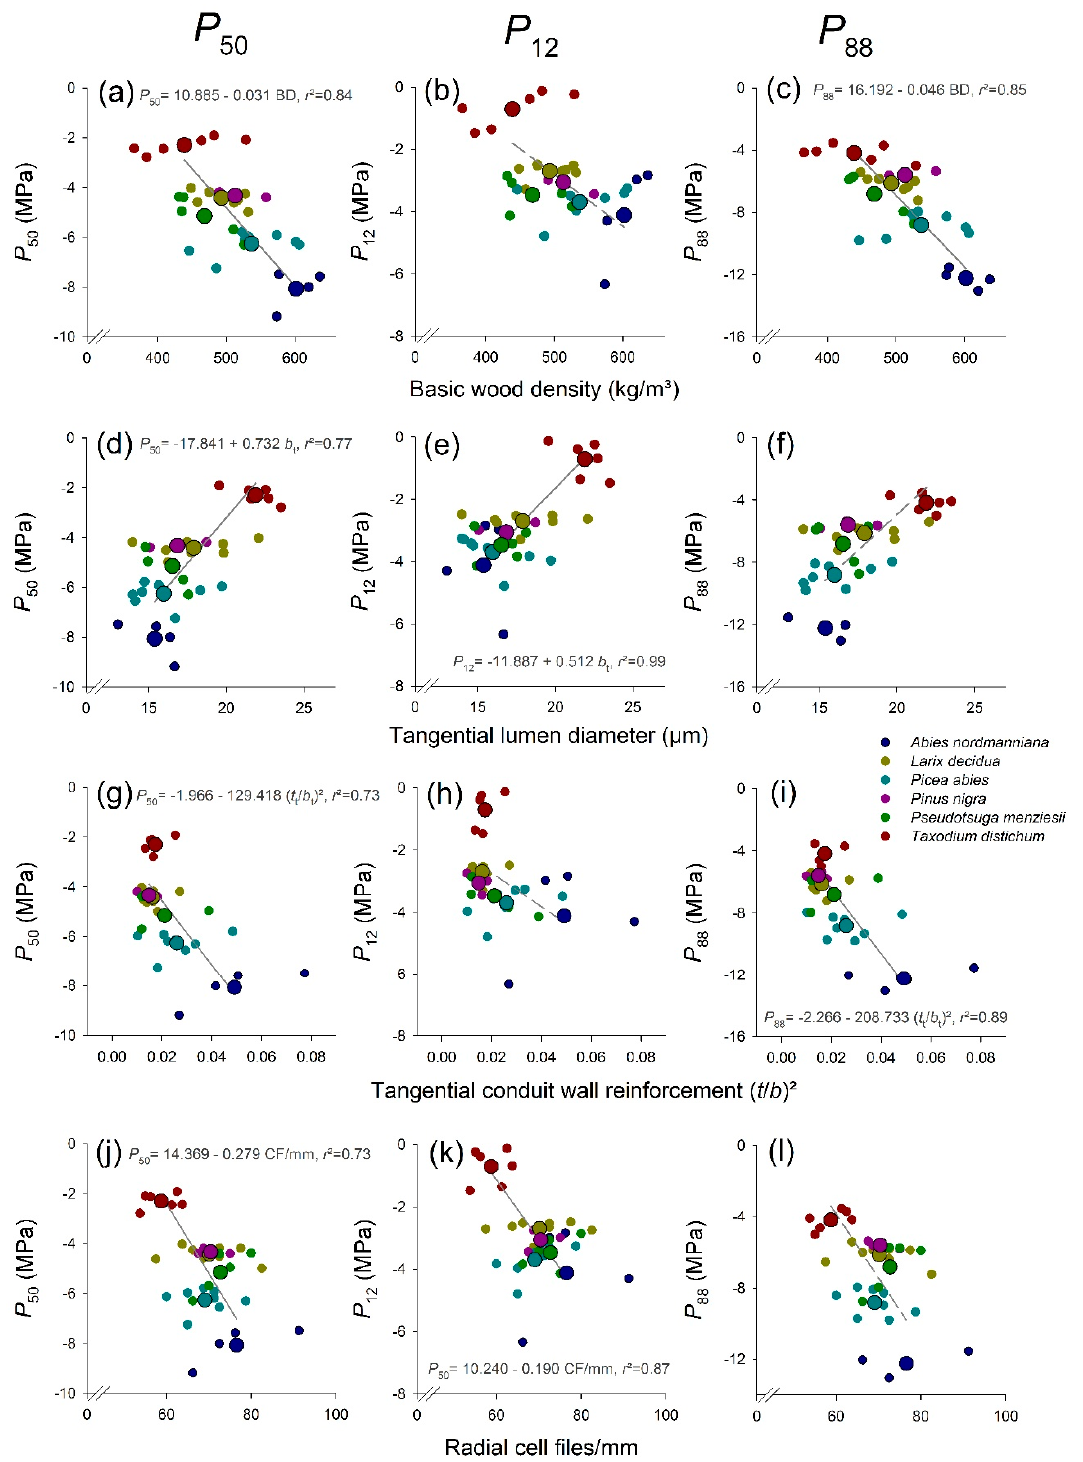
Figure 4. Structure–function relationships of sapwood across conifer species. P 50 , P 12 and P 88 are plotted against ( a – c ) basic wood density, ( d – f ) tangential lumen diameter of earlywood tracheids, ( g – i ) tangential conduit wall reinforcement of earlywood and ( j – l ) to the number of radial cell files/mm of six conifer species, indicated by different colors. Small dots indicate single samples (vulnerability curves), big dots species mean values. Solid lines denote significant linear relationships for species mean values and hatched lines represent linear regression lines that are not significant.